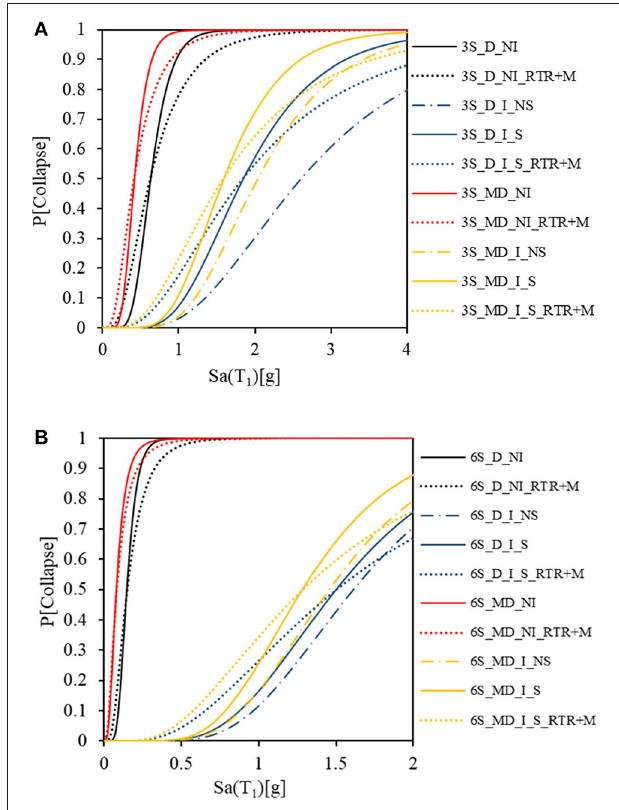
FIGURE 8 | Fragility curves of (A) 3-story and (B) 6-story MRF RC frame with and without URM infill walls.